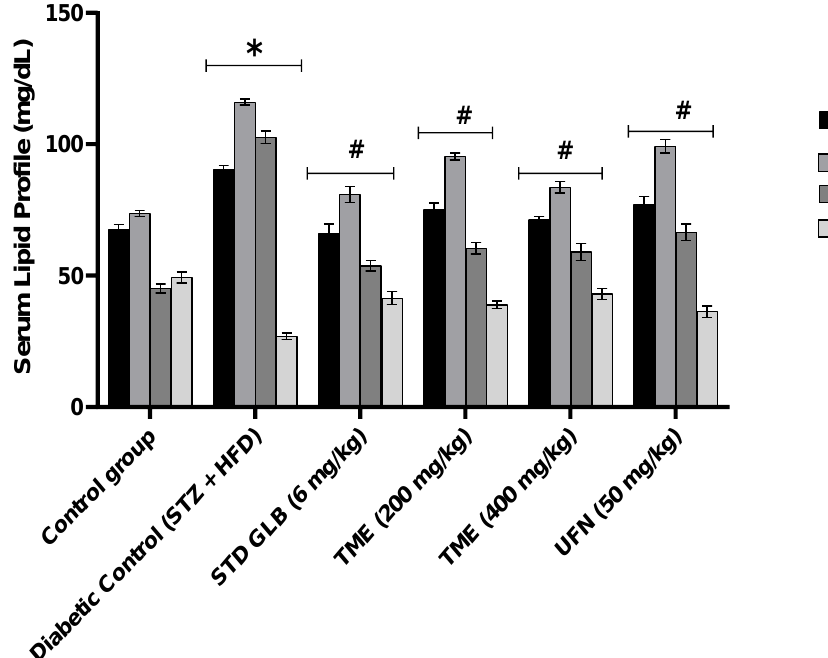
Figure 3. Effect of TME (200 and 400 mg/kg) of B. eriophora and UFN on serum lipid profile. Values are represented as mean ± SD, n = 6. * represents a significant difference between the control group and the diabetic control group. Whereas # represents a significant difference between the diabetic control group with all the treatment groups of TME and UFN. TC; total cholesterol, TRG; triglycerides, LDL; low-density lipoprotein, HDL; high-density lipoprotein, STZ; streptozotocin, STD GLB; standard glibenclamide, TME; total methanol extract, UFN; umbelliferon.